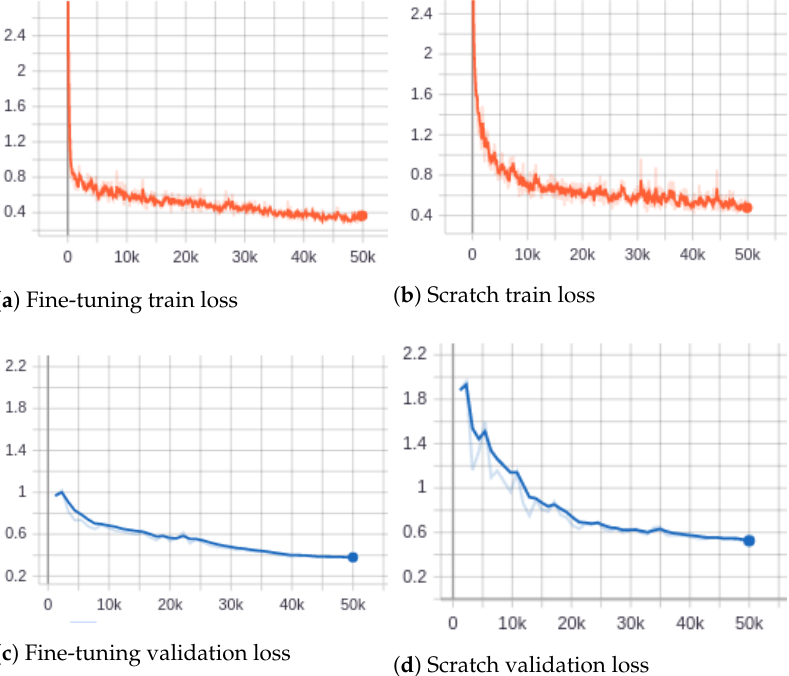
Figure 11. Train and validation loss of SSD MobileNet-V1 using 50,000 epochs and considering Transfer Learning and training from scratch.